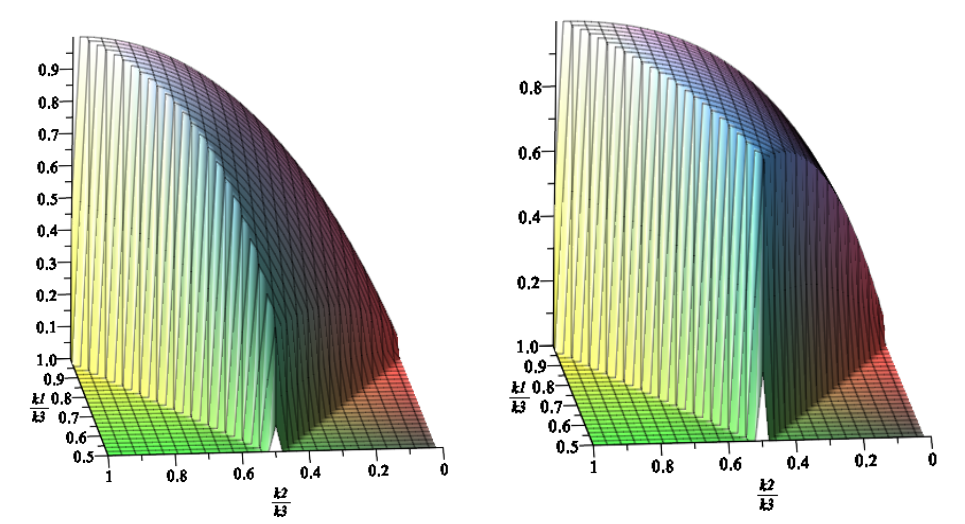
(right): both of them have a peak at the equilateral 3pt